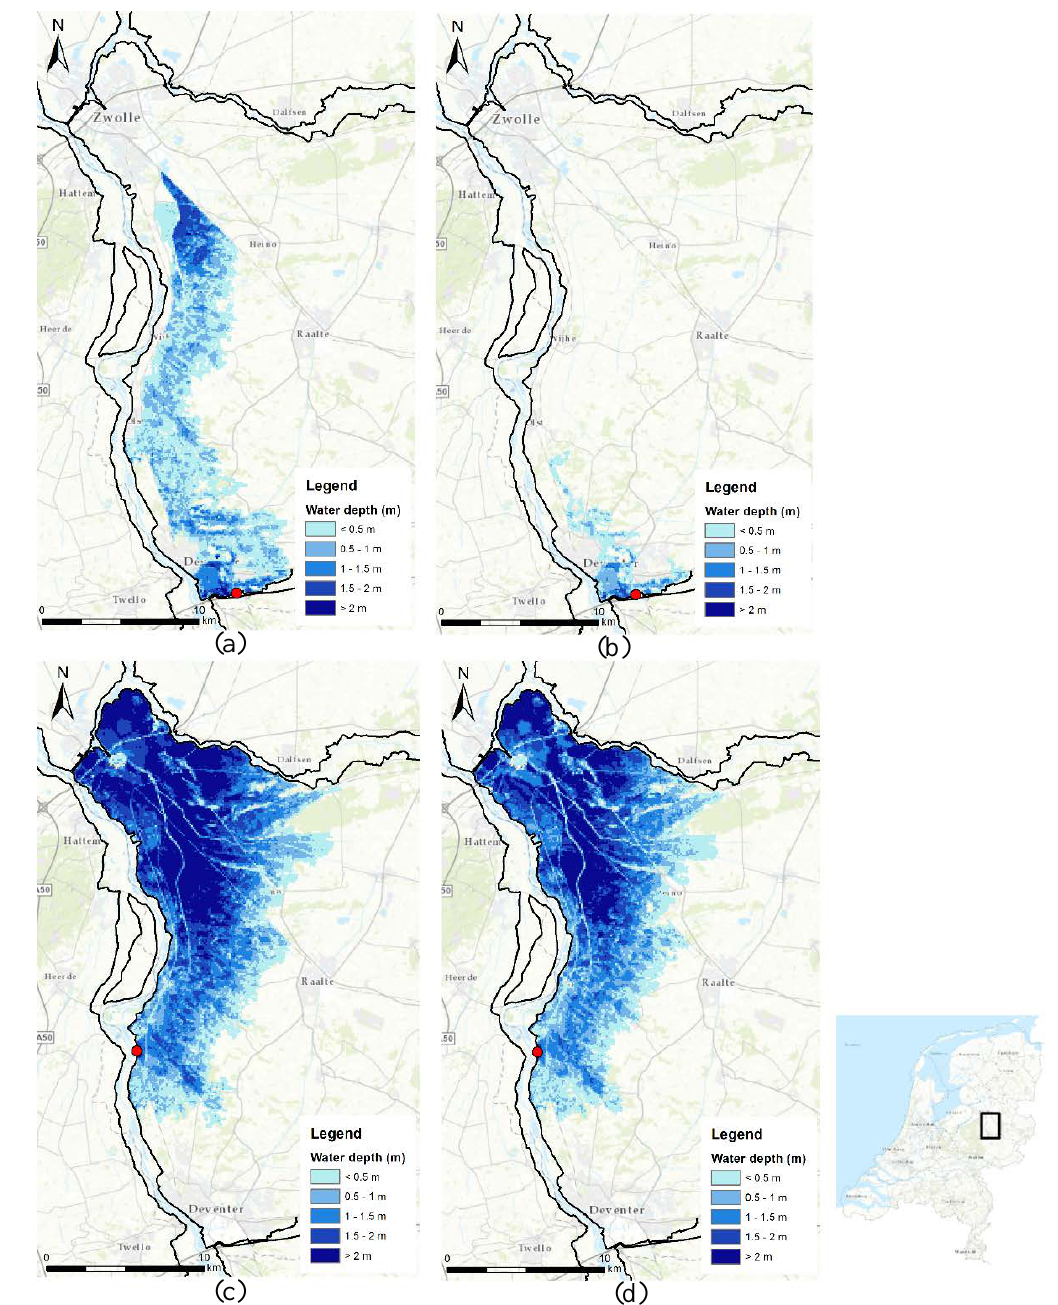
Figure 4. Water depth and flooded area as a function of location of breaching (red dot) and flood level in the river in case of a breach of the eastern embankment of the IJssel River at Deventer ( a , b ) or Olst ( c , d ). Breaching under design flood level conditions ( a , c ) and breaching at water levels that are about 0.7 m lower due to enhanced conveyance capacity ( b , d ). (source: inundation simulations made for VNK2 and collected by IPO and RWS in the context of the implementation of the EU Flood